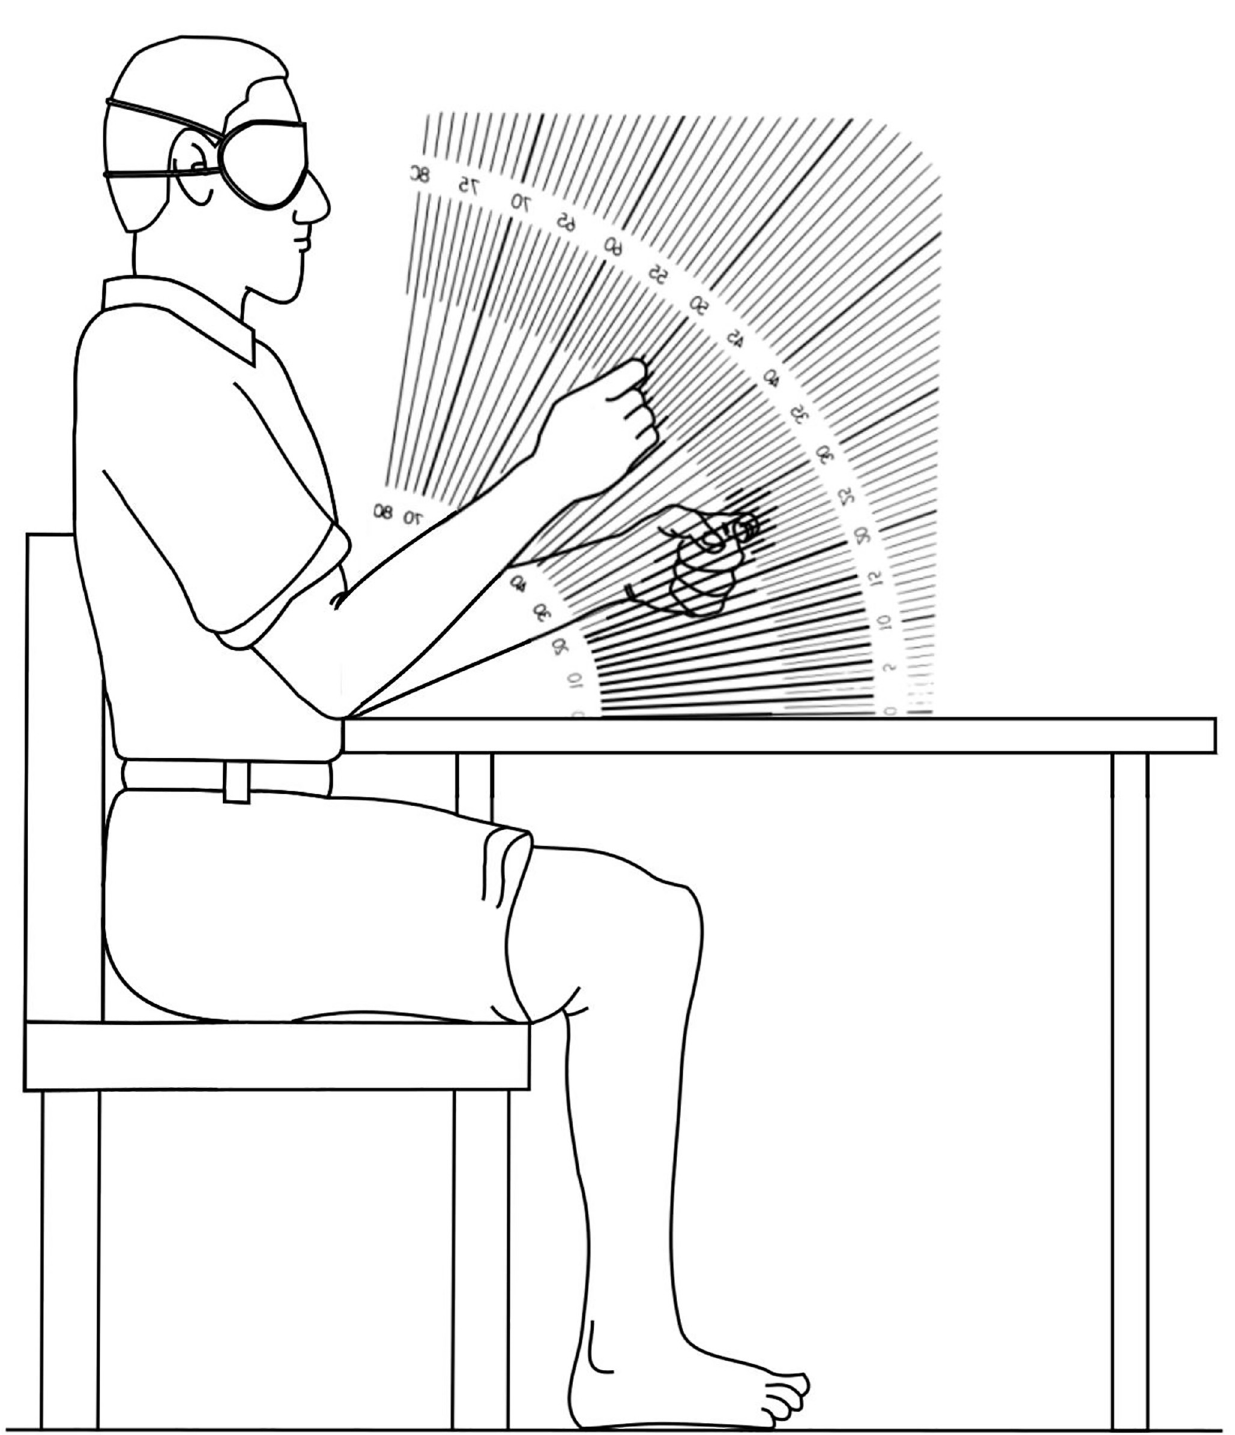
Fig 4. Position sense. The blindfolded participant attempted to match the position of their non-dominant index finger (passively positioned by the examiner) with their dominant index finger by bending their elbow. For each trial, the difference in degrees between both index fingers was recorded. The average error in absolute terms of the five trials was then recorded as the participant’s